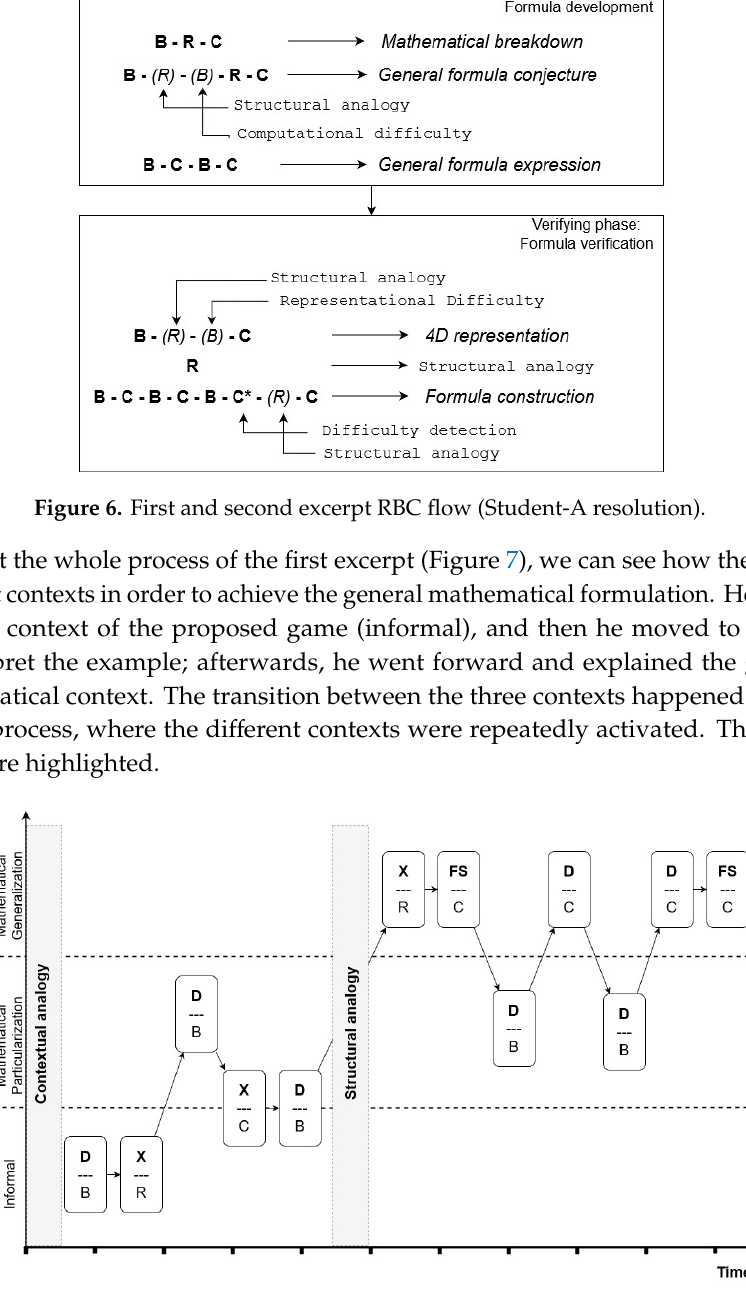
Figure 7. Pattern in epistemic actions and context (first excerpt diagram).